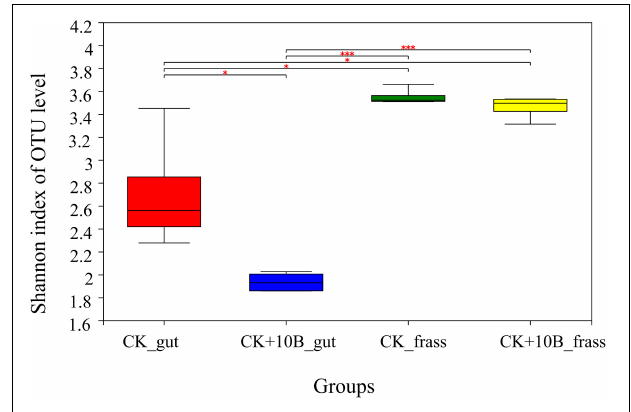
FIGURE 2 | The Shannon index of gut microbiota in the CK_gut, CK+10B_gut, CK_frass, and CK+10B_frass groups. Pair-wise ANOVA was performed between different groups. “ ∗ ” indicates p < 0.05; “ ∗∗∗ ” indicates p < 0.001. CK_gut, intestinal microbiota of BSFL; CK_frass, frass microbiota of BSFL; 10B_gut, intestinal microbiota of BSFL inoculated with 10B; 10B_frass, frass microbiota of BSFL inoculated with 10B.